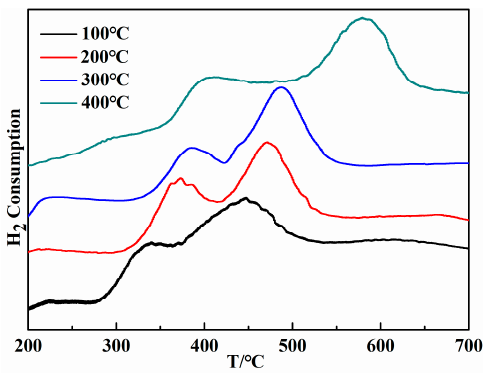
Figure 9. The TPR profiles of 10 wt% NiP/H β calcined at different temperatures.